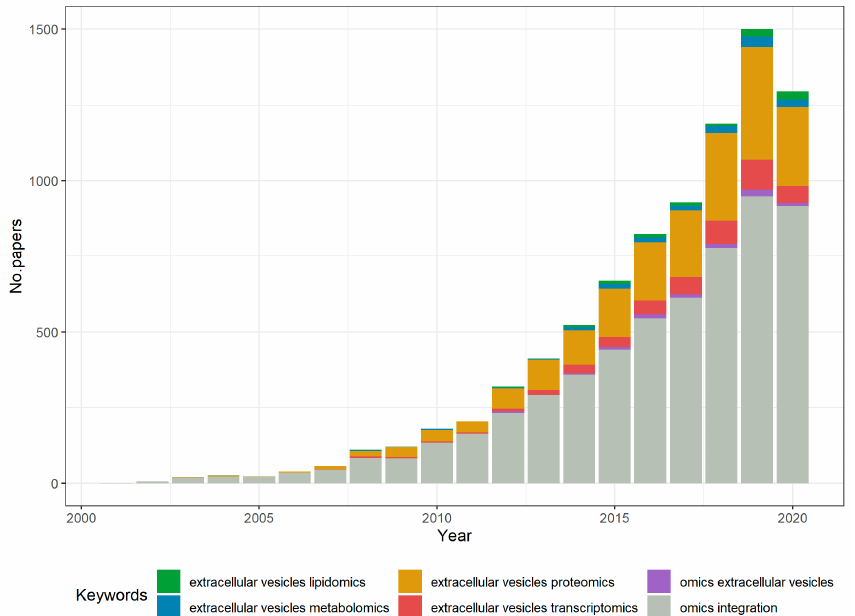
Figure 1. Evolution of interest in omics studies for EVs, according to the number of annual publications on PubMed. Stacked histogram created using R software [63].